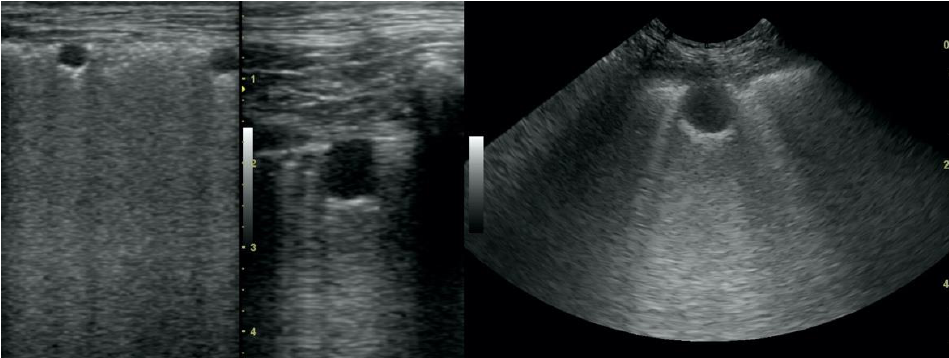
Figure 8. Nodule sign in the course of lung cancer.